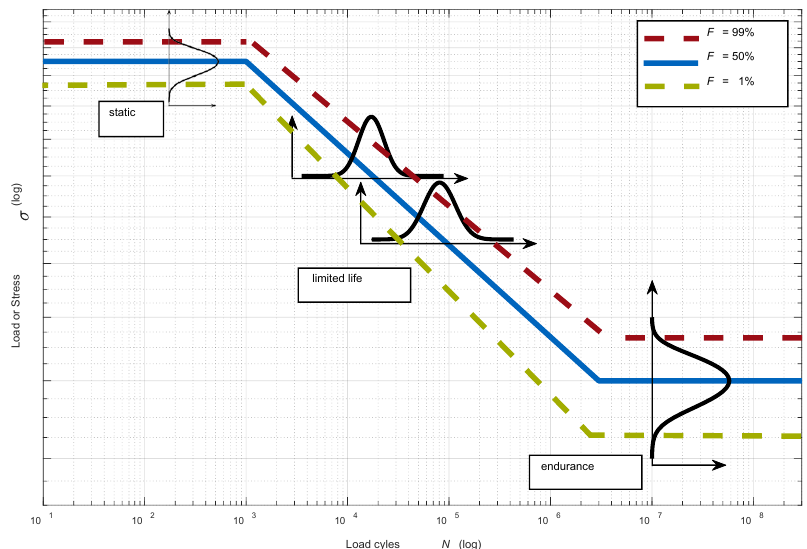
Figure 4. SN curves for different failure probabilities by assumption of separated consideration of long-life (endurance) and limited-life ranges [24]. Extracted from AGMA 18FTM26, Reliability of Gears—Determination of Statistically Validated Material Strength Numbers, with the permission of the publisher, the AmericanGear Manufacturers Association, 1001 North Fairfax Street, Suite 500, Alexandria, Virginia 22314.